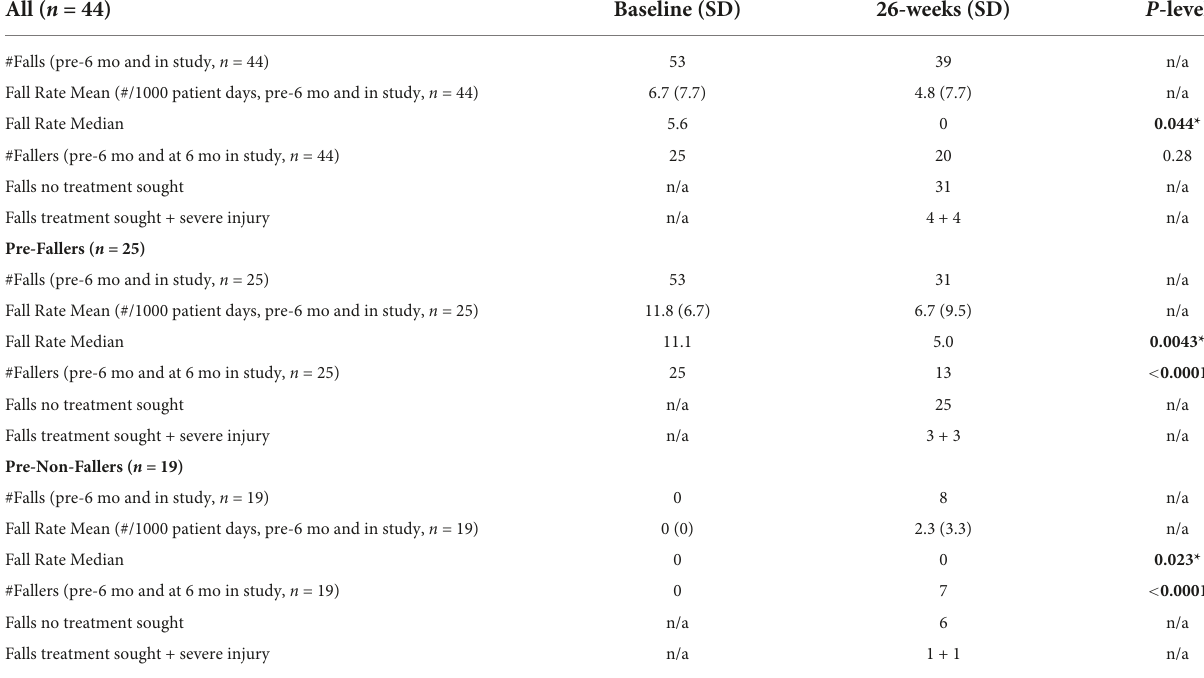
TABLE 5 Parameters related to falls and fall risk assessed at baseline and at 26